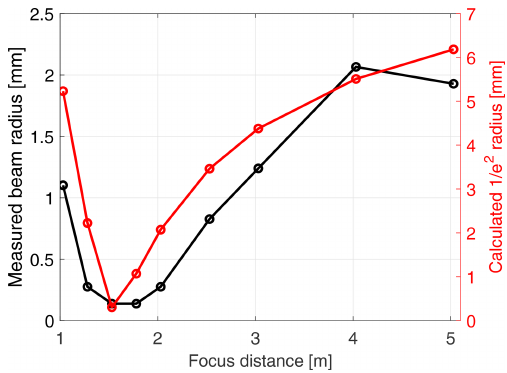
Figure 8. Comparison between the measured beam widths and the theoretically calculated 1 /e 2 radius as a function of focus distance.